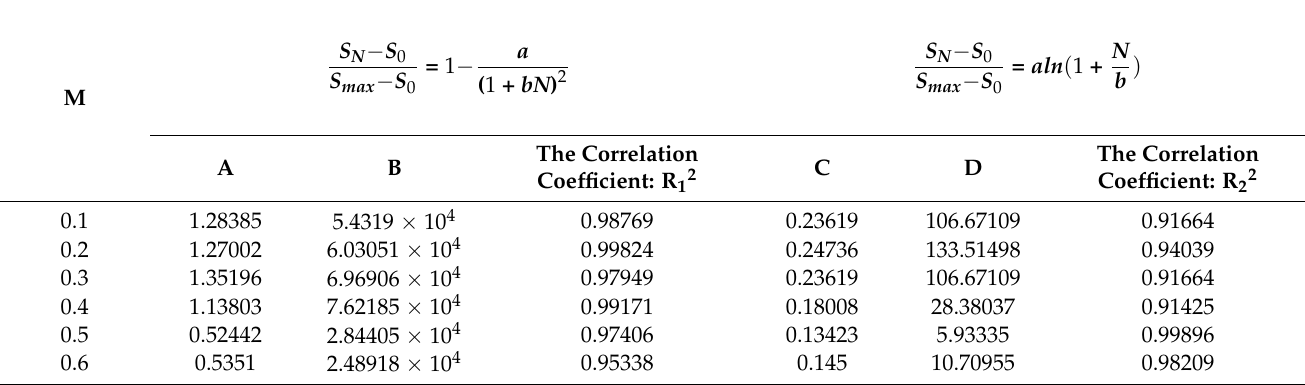
Table 4. The S N – N fitting curve